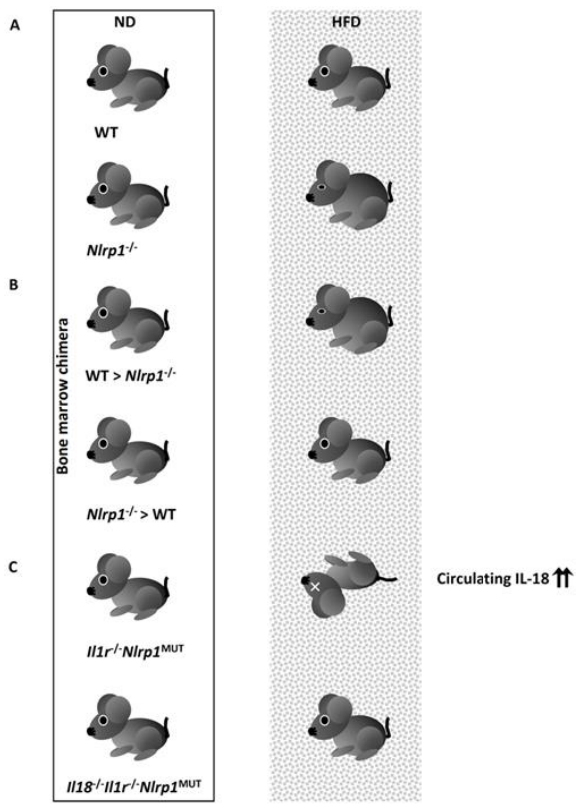
Figure 4. Involvement of the NLRP1 inflammasome in non-hematopoietic cells on metabolic homeostasis. ( A ) Requirement of NLRP1 for metabolic homeostasis: Nlrp1 − / − mice spontaneously develop obesity and related metabolic syndromes when fed a normal diet (ND) that does not induce obesity in wild type (WT) mice. Nlrp1 − / − mice fed a high-fat diet (HFD) had a more severe illness compared with WT mice. ( B ) IL-18 is released after activation of NLRP1 in non-hematopoietic cells. Nlrp1 − / − mice reconstituted with WT bone marrow cells ( Nlrp1 − / − > WT) showed a phenotype similar to Nlrp1 − / − mice. In contrast, WT mice reconstituted with Nlrp1 − / − bone marrow cells (WT > Nlrp1 − / − ) exhibited a phenotype comparable with WT mice. ( C ) The protective role of IL-18 against cachexia. Il1r − / − Nlrp1 MUT mice harboring a mutant gene from human patients with familial Mediterranean fever but lacking the IL-1R gene have an almost intact phenotype when fed a ND. However, when fed an HFD, Il1r − / − Nlrp1 MUT mice suffered from fatal illness with a marked increase in circulating IL-18 levels. By contrast, Il18 − / − Il1r − / − Nlrp1 MUT mice were resistant to HFD.